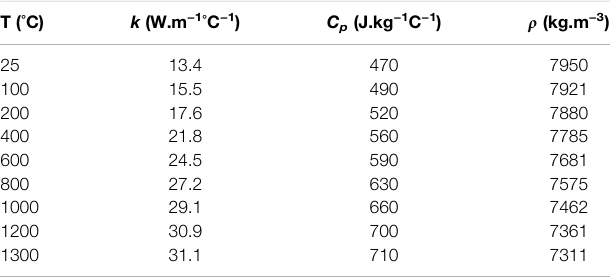
TABLE1| TemperaturedependentmaterialpropertiesofSS316L(MillsandMills, 2002). T ( °